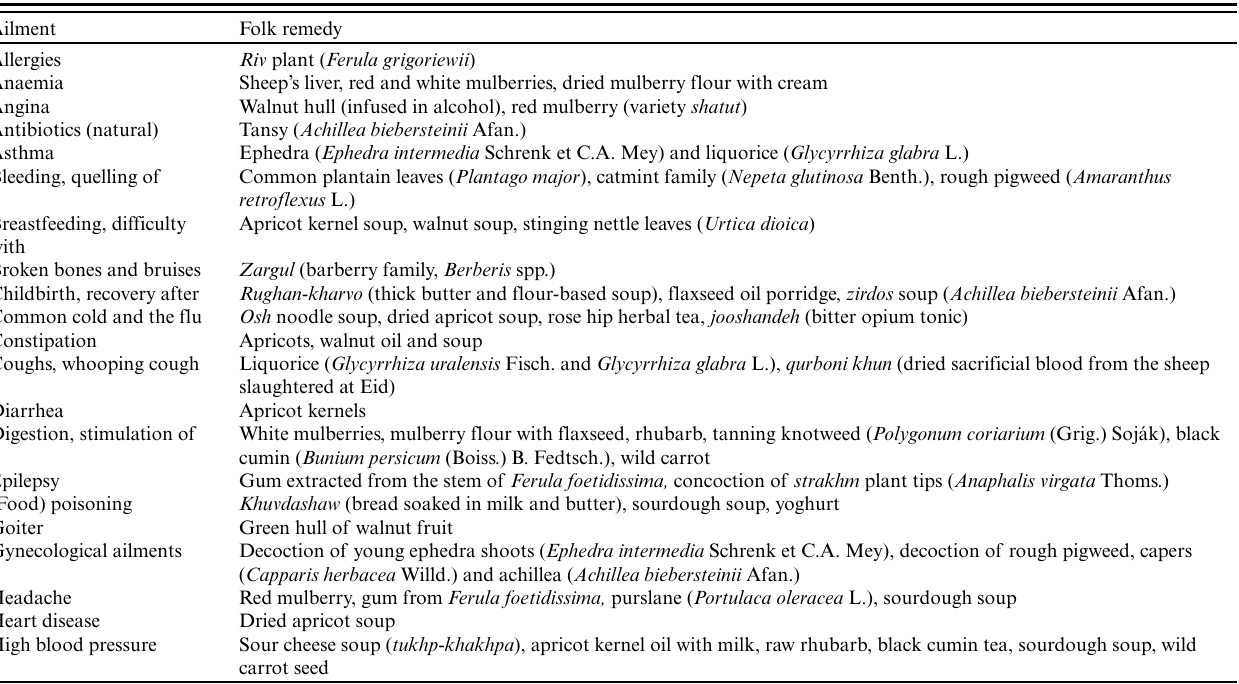
Table 2. A partial alphabetical list of illnesses and the folk remedies used to treat them in the Pamirs. For the complete list, including ailments listed from I–Z, see Van Oudenhoven and Haider